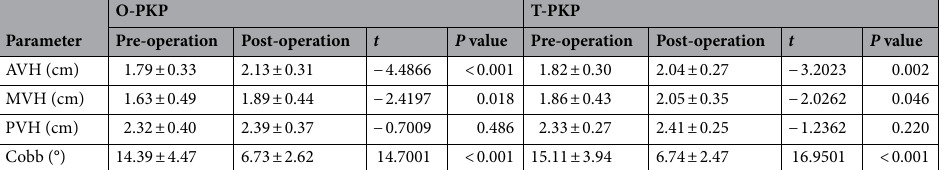
Table 3. The height of vertebral body and Cobb angle were evaluated at pre-operation and post-operation. AVH, anterior vertebral height; MVH, middle vertebral height; PVH, posterior vertebral height. The data were analyzed by